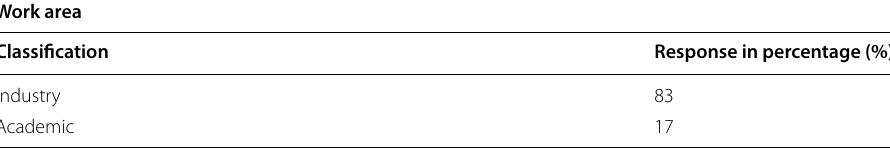
Table 2 Work area of the participants Work